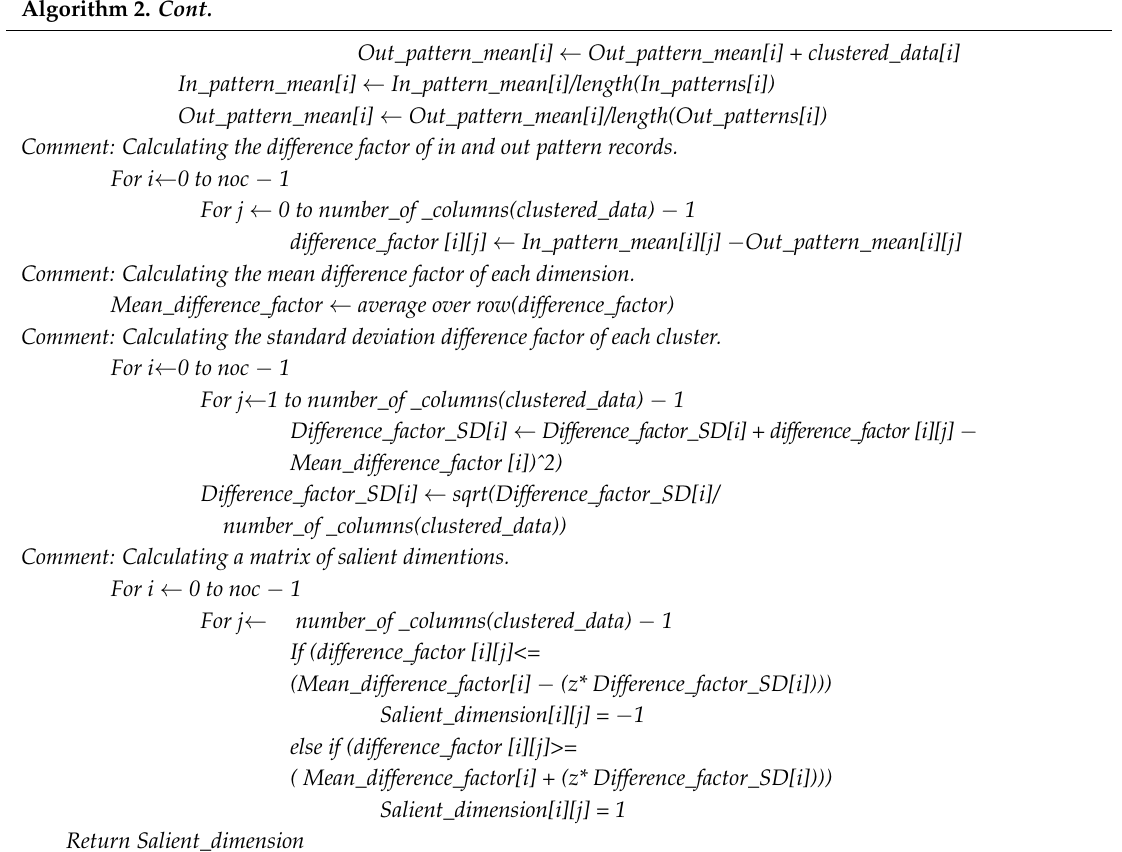
Algorithm 2. Cont.